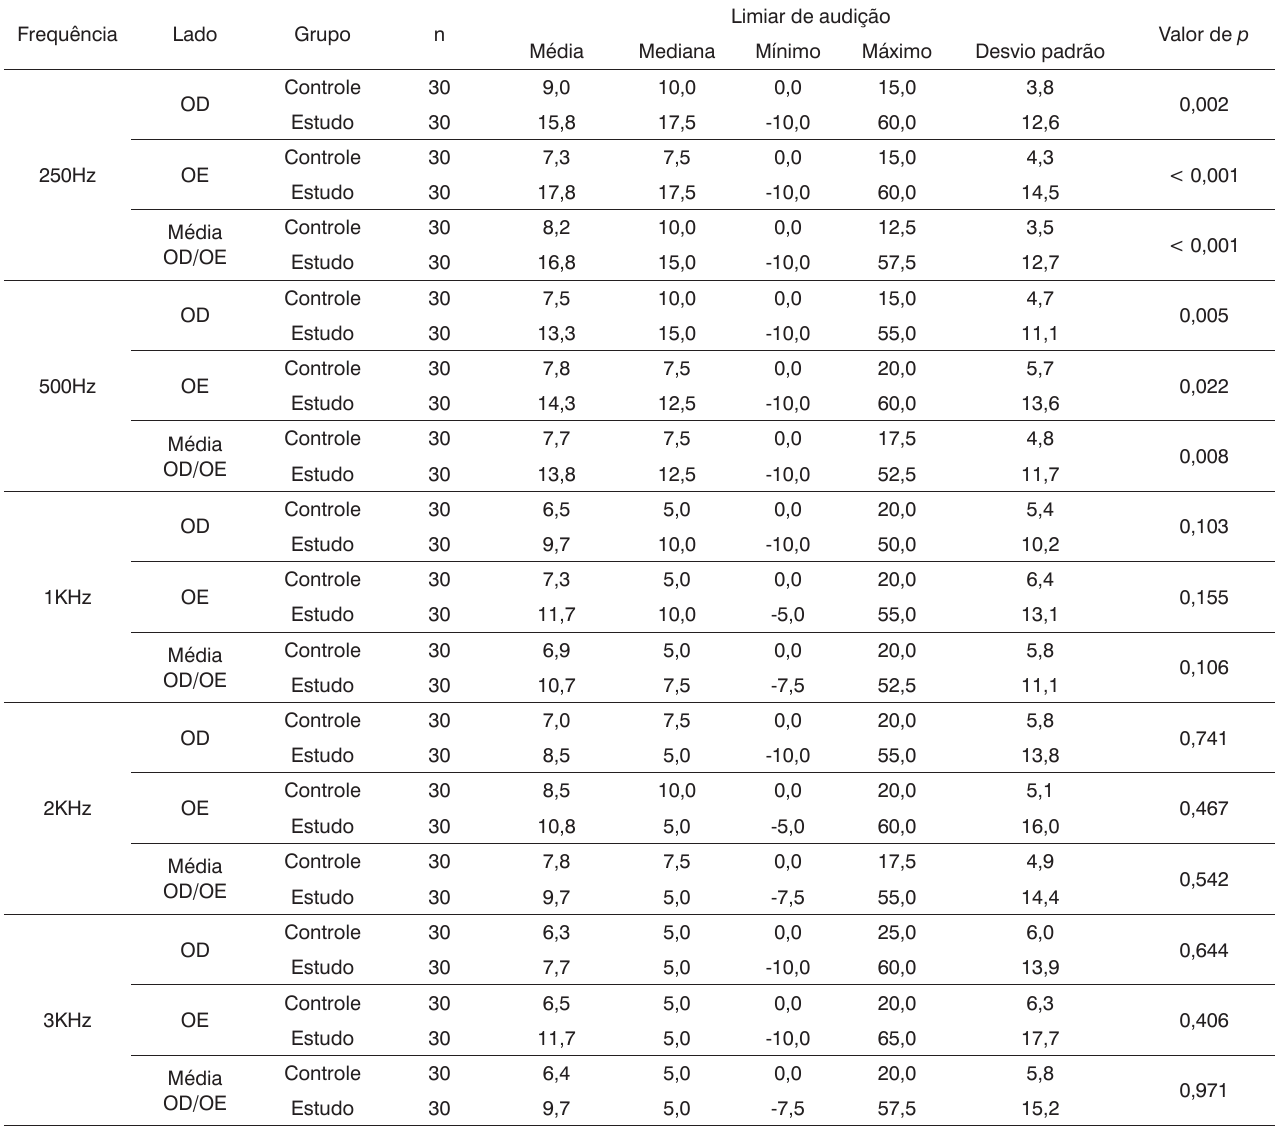
Tabela 1. Estudo descritivo dos limiares de audibilidade dos GC e GE nas orelhas direita (OD) e esquerda (OE), nas frequências de 250 até 16000